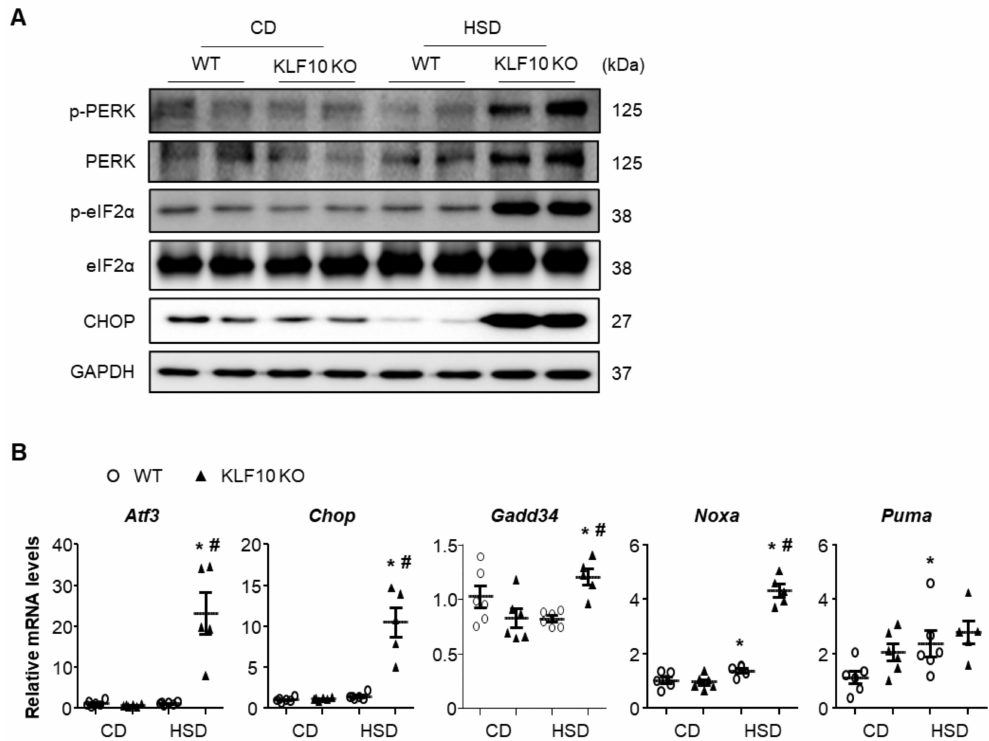
Figure 4. Klf 10 deletion activates the proapoptotic PERK-CHOP pathway upon high-sucrose feeding. Eight-week-old WT and Klf 10 KO mice were fed either CD or HSD for eight weeks (n = 5–6 mice/group). ( A ) Western blot analysis of p-PERK, PERK, p-eIF2 α , eIF2 α , and CHOP in the livers of WT and Klf 10 KO mice fed either CD or HSD. ( B ) Relative expression of genes involved in ER stress ( Atf3 , Chop , Gadd 34, Noxa , and Puma ) in the liver was analyzed via qPCR. Target gene expression was normalized to the expression of Rplp0 . All data are representative of at least three independent experiments and expressed as mean ± SEM. Charts were produced using GraphPad Prism 5.0. Statistical differences were determined by two-way ANOVA with Mann–Whitney U test using SPSS v17.0. * p < 0.05 vs. genotype-matched, CD-fed group and # p < 0.05 vs. diet-matched, genotype control. WT, wild type; KO, knockout; CD, control chow diet; HSD, high-sucrose